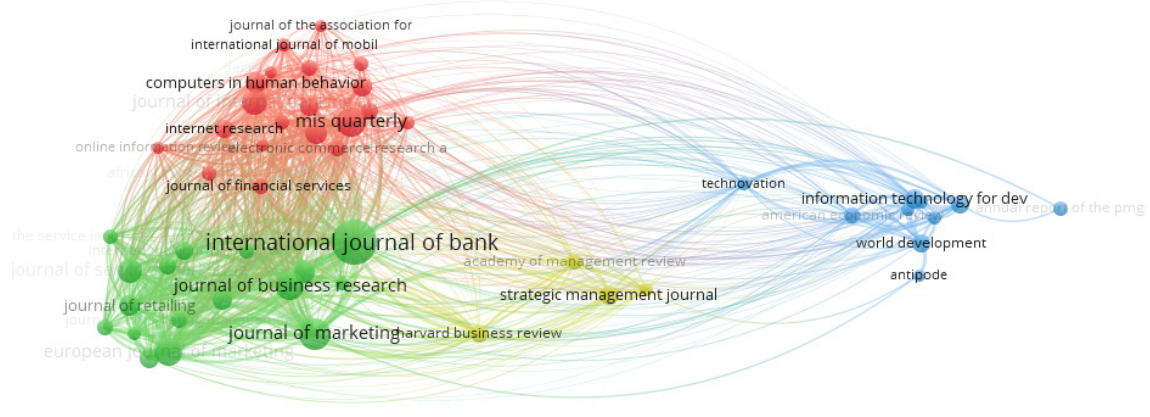
Figure 2. Output distribution by sources Table 1. Co-citation outputs by source and citation analysis Top 10 outputs by journal